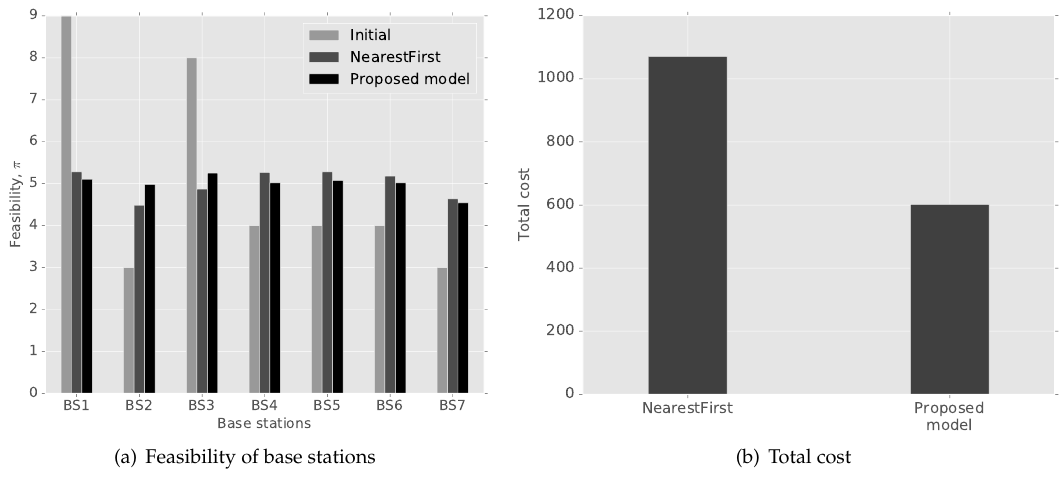
Figure 3. Feasibility of base stations and the total cost of cluster heads with TDMA